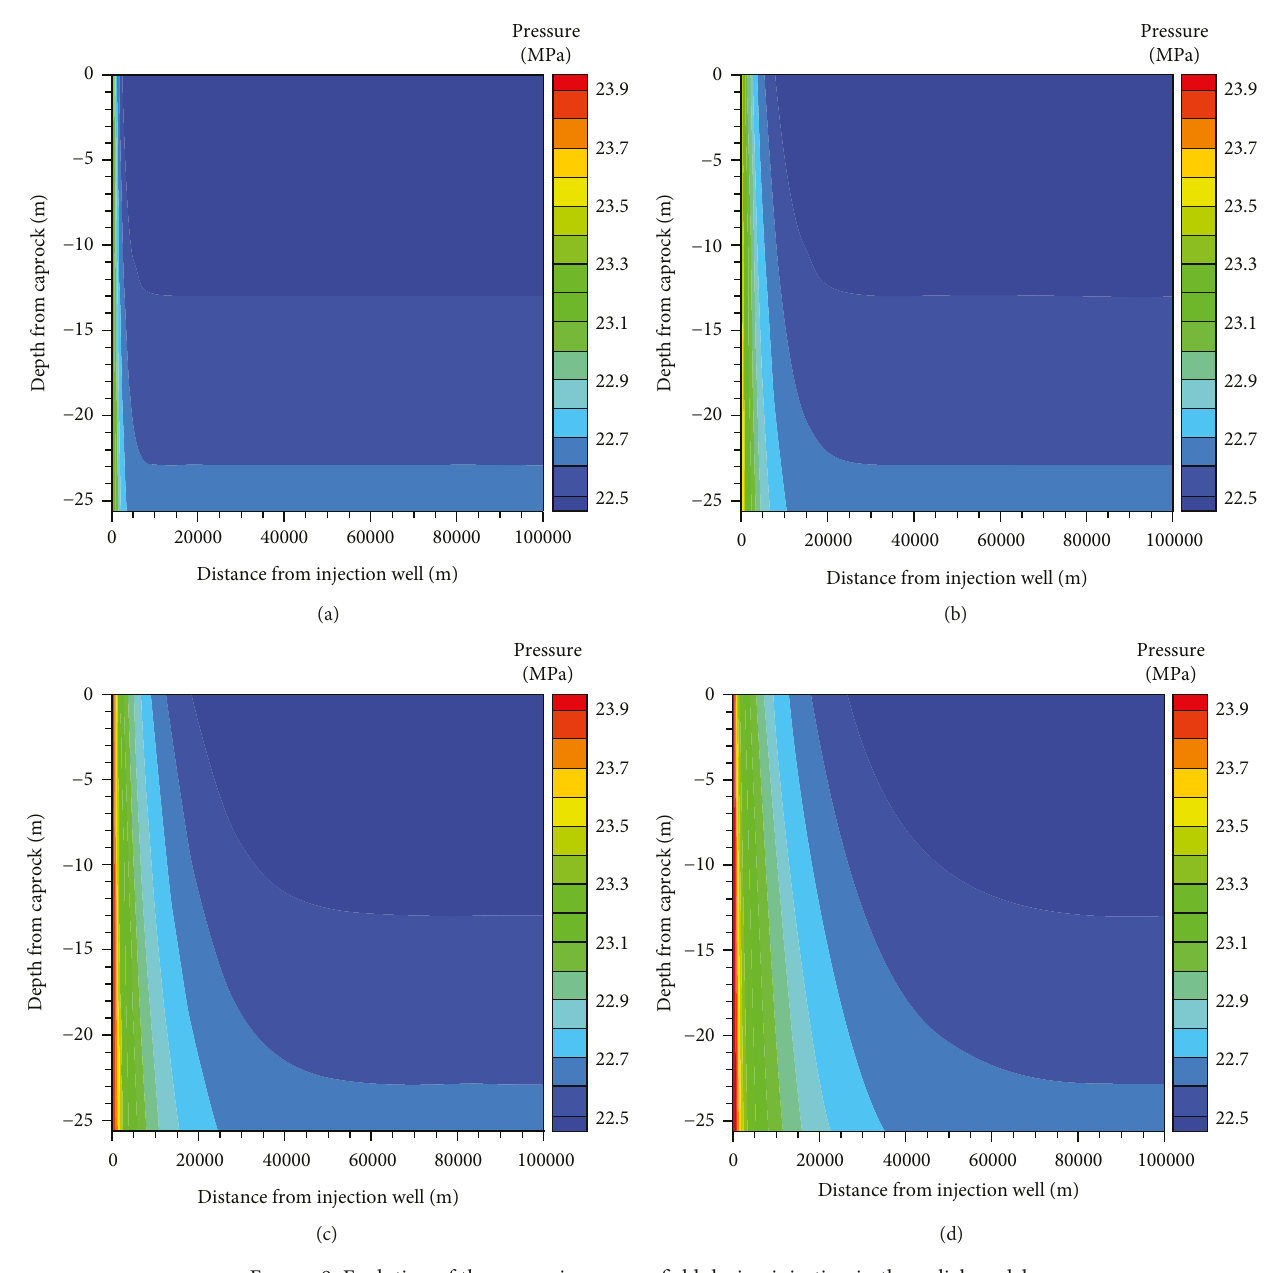
Figure 9: Evolution of the reservoir pressure fi eld during injection in the radial